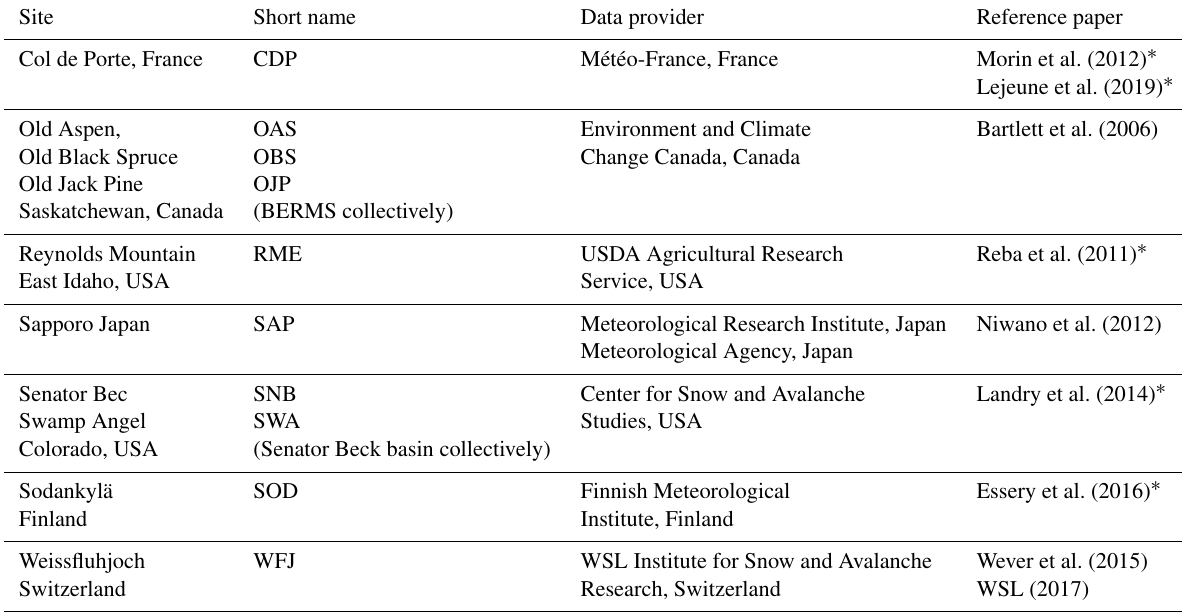
Table 1. Data ownership and reference papers for the sites. Asterisks denote dedicated data description papers; the others are modelling papers in which a short description of a site is included.